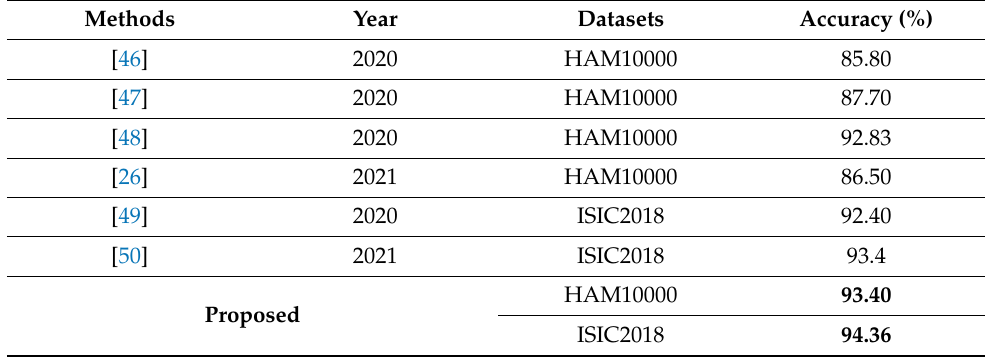
Table 9. Comparison of the proposed method accuracy with SOTA